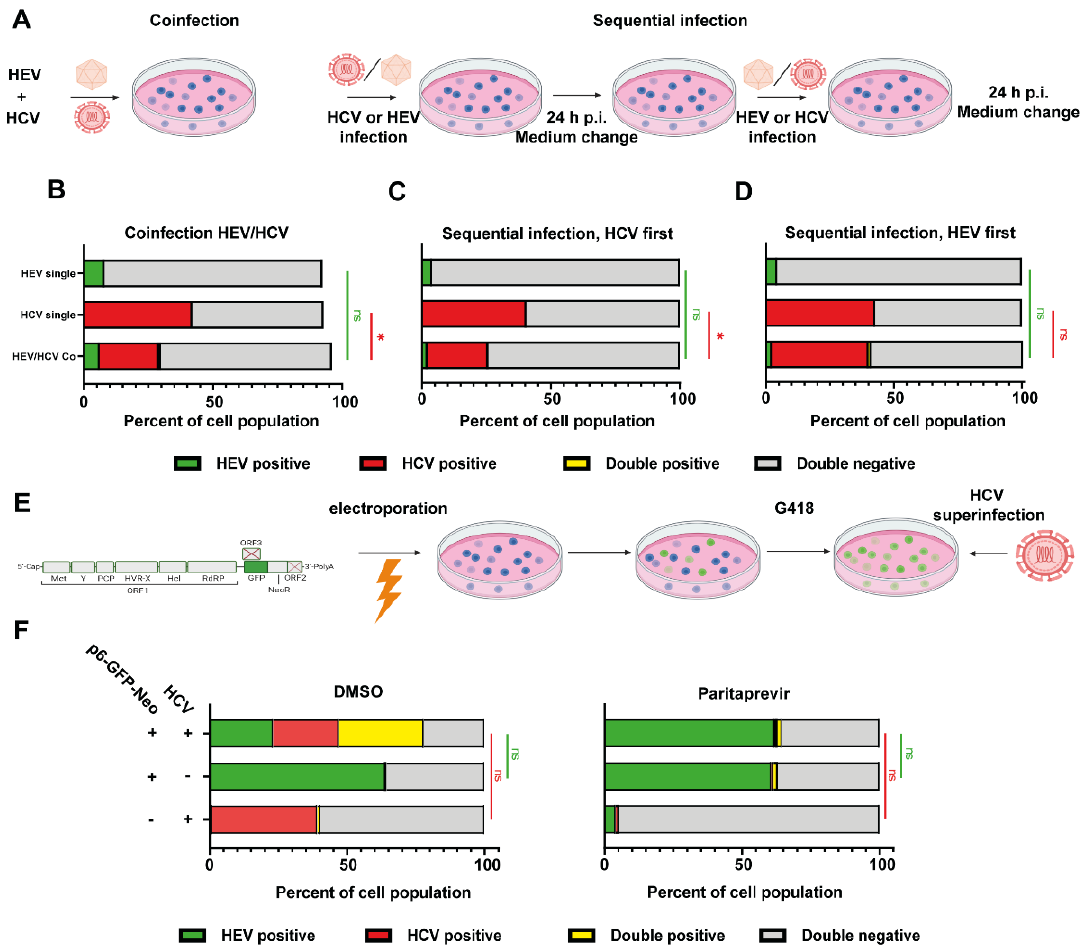
Figure 5. Co-infection and sequential super-infection with HCVcc and HEVcc. ( A ) Schematic representation of experimental setup for panels ( B – D ): Huh7.5 cells were co-infected with HEVcc (based on Kernow-C1 p6 strain) and HCVcc (based on Jc1). HEV and HCV inoculum were incubated on the cells for 24 h, either together ( B ), or sequentially ( C , D ). Four days post infection, cells were analyzed with immunofluorescence against HEV capsid protein ORF2. The number of foci was manually counted. Depicted are mean percentage ± SD of positive cells from three independent experiments for HEV, HCV, none or both as determined via image analysis with Cell Profiler. (Two-way ANOVA with Tukey’s multiple comparison test on normalized infection events). ( E ) Schematic representation of experimental setup for panel ( F ): Huh7.5 hepatoma cells were transfected with a HEV subgenomic GFP-reporter replicon comprised of all non-structural proteins of HEV Kernow-C1 p6. Cells were selected and maintained analogous to Huh7 Lunet sg/neo cells. ( F ) Five days after super-infection with HCV, the cells were analyzed by immunofluorescence. Graphs show mean percentage of positive cells ± SD of three independent experiments for HEV, HCV, none or both as determined via image analysis with Cell Profiler. Cells were treated with DMSO or 10 µ M paritaprevir. Treatment was started 4 h post electroporation. (Two-way ANOVA with Tukey’s multiple comparison test on normalized infection events). * = p value < 0.05.